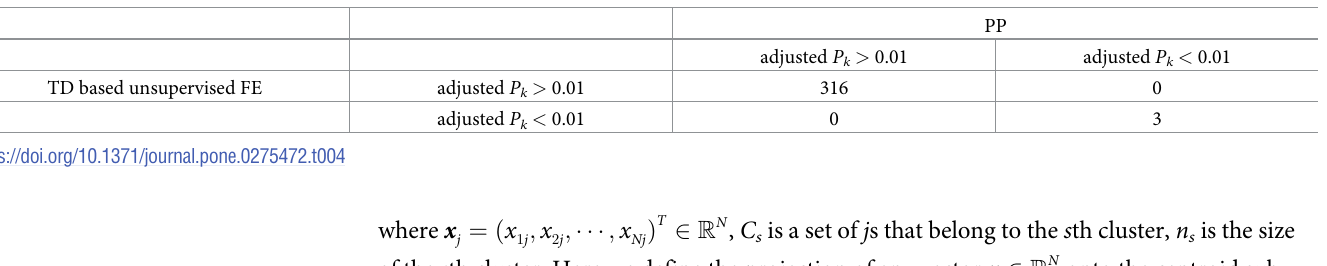
Table 4. Confusion matrix of selected miRNAs between TD based unsupervised FE and PP in the second data set. P -value computed by Fisher’s exact test is 1.87 × 10 − 7